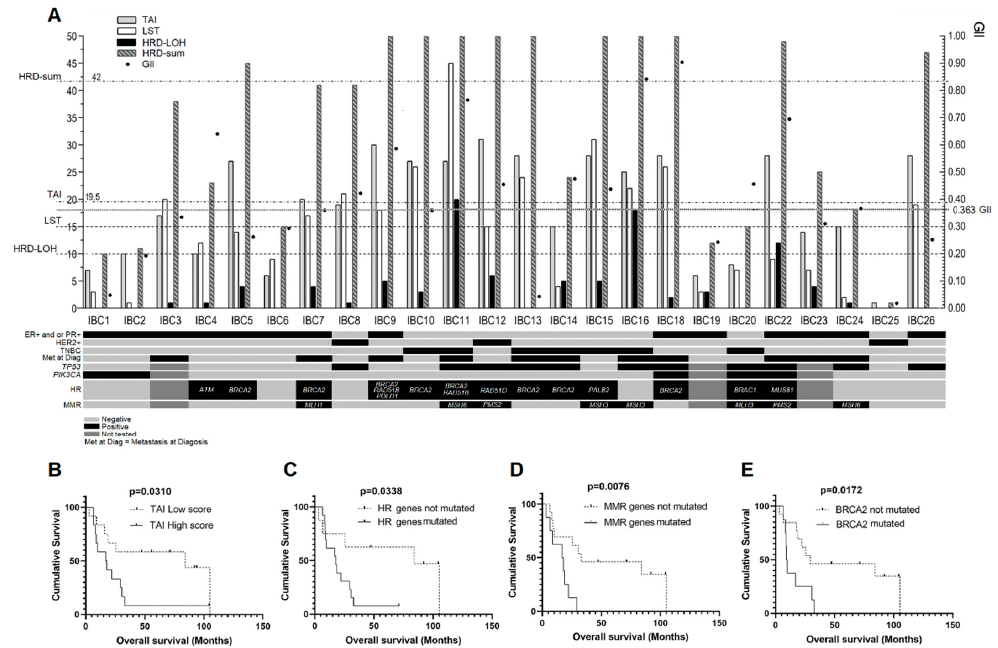
Figure 2. Graphical representation of homologous recombination deficiency (HRD)-associated scores (TAI, LST, HRD-LOH, and HRD-sum) and GII. ( A ) The dashed lines represent the thresholds for high and low scores. Cases with variants in homologous recombination (HR) genes, TP53, PIK3CA and mismatch repair (MMR) genes are also indicated. For the HR and MMR genes, the specific altered genes are shown, while variants in TP53 and PIK3CA are represented by the plus sign (+). For technical issues, IBC3, IBC9, and IBC23 were not submitted to sequencing analysis. ( B ) Significant differences in overall survival curves according to TAI status. ( C ) HR variants. ( D ) MMR variants. ( E ) BRCA2 variants.